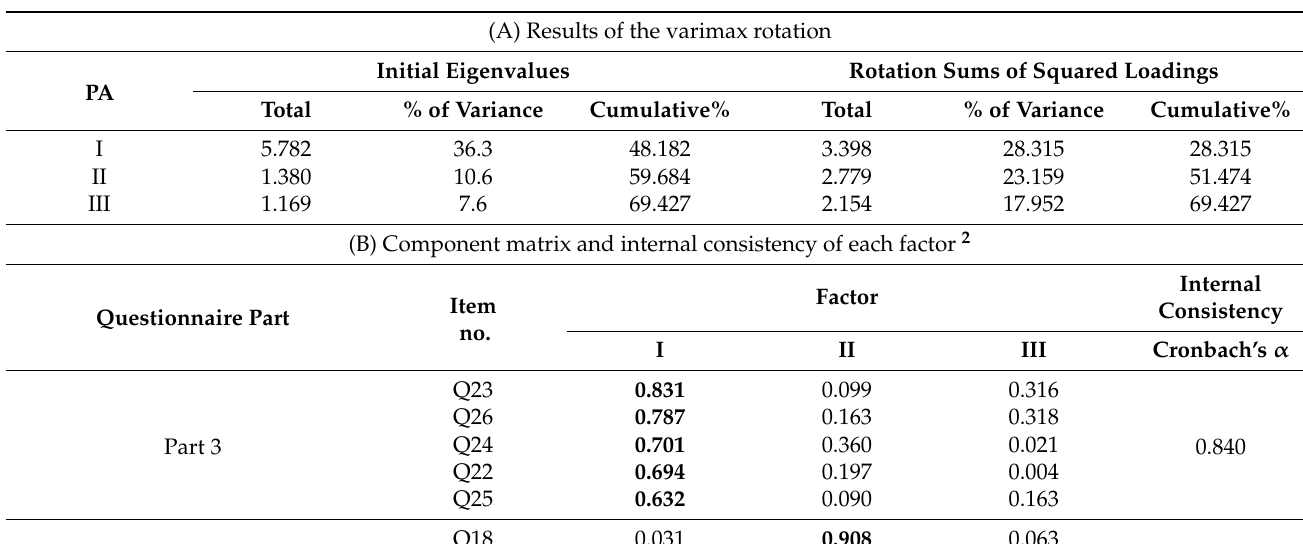
Table 2. Factor analysis of the 5-point Likert-scale items in parts 2 and 3 of the questionnaire 1